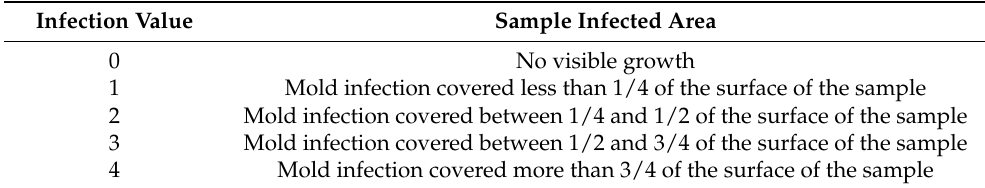
Table 3. Reference for evaluation of infection